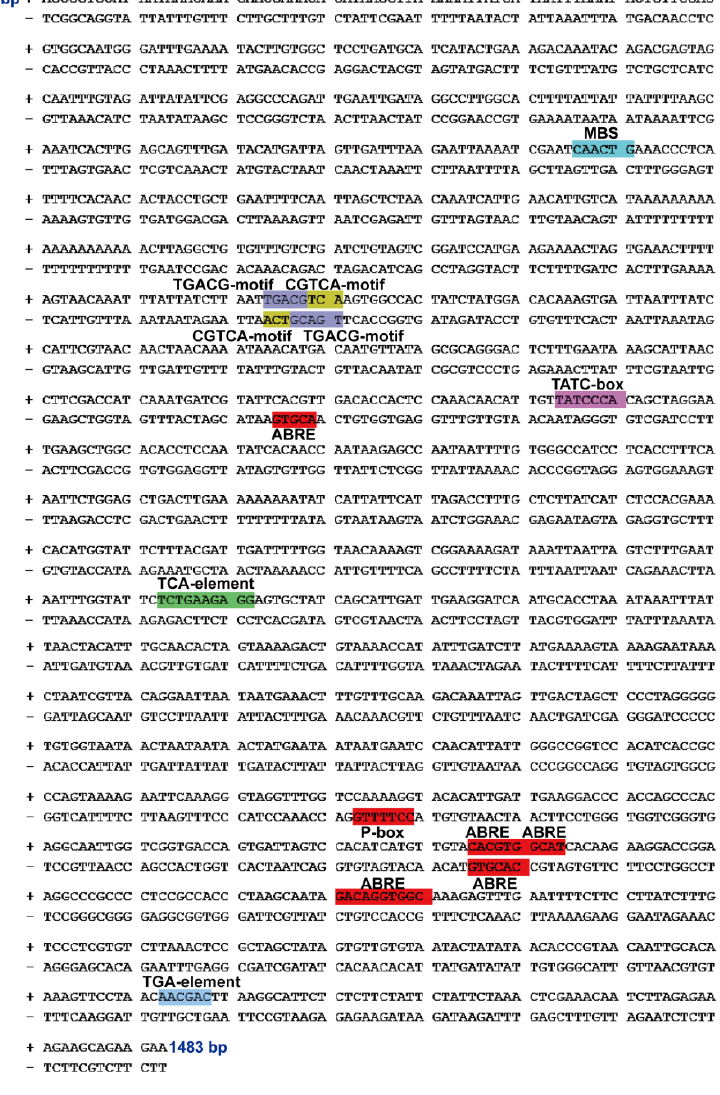
Figure 3. The 1.483 kb promoter sequence and cis -acting element distribution of the GmTIP1;6 . + and − represented the sense and antisense strand, respectively. Different elements with different core sequences in the promoter were marked by different colors.